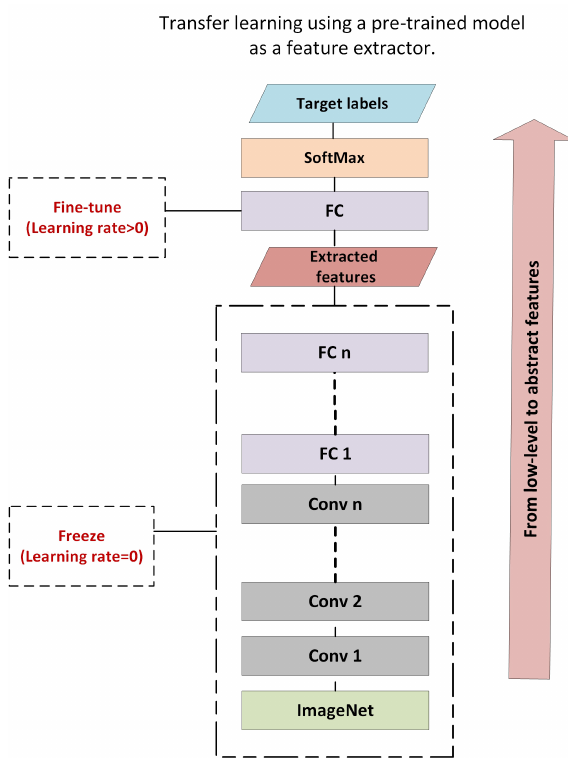
Figure 3. Feature Extraction using Transfer